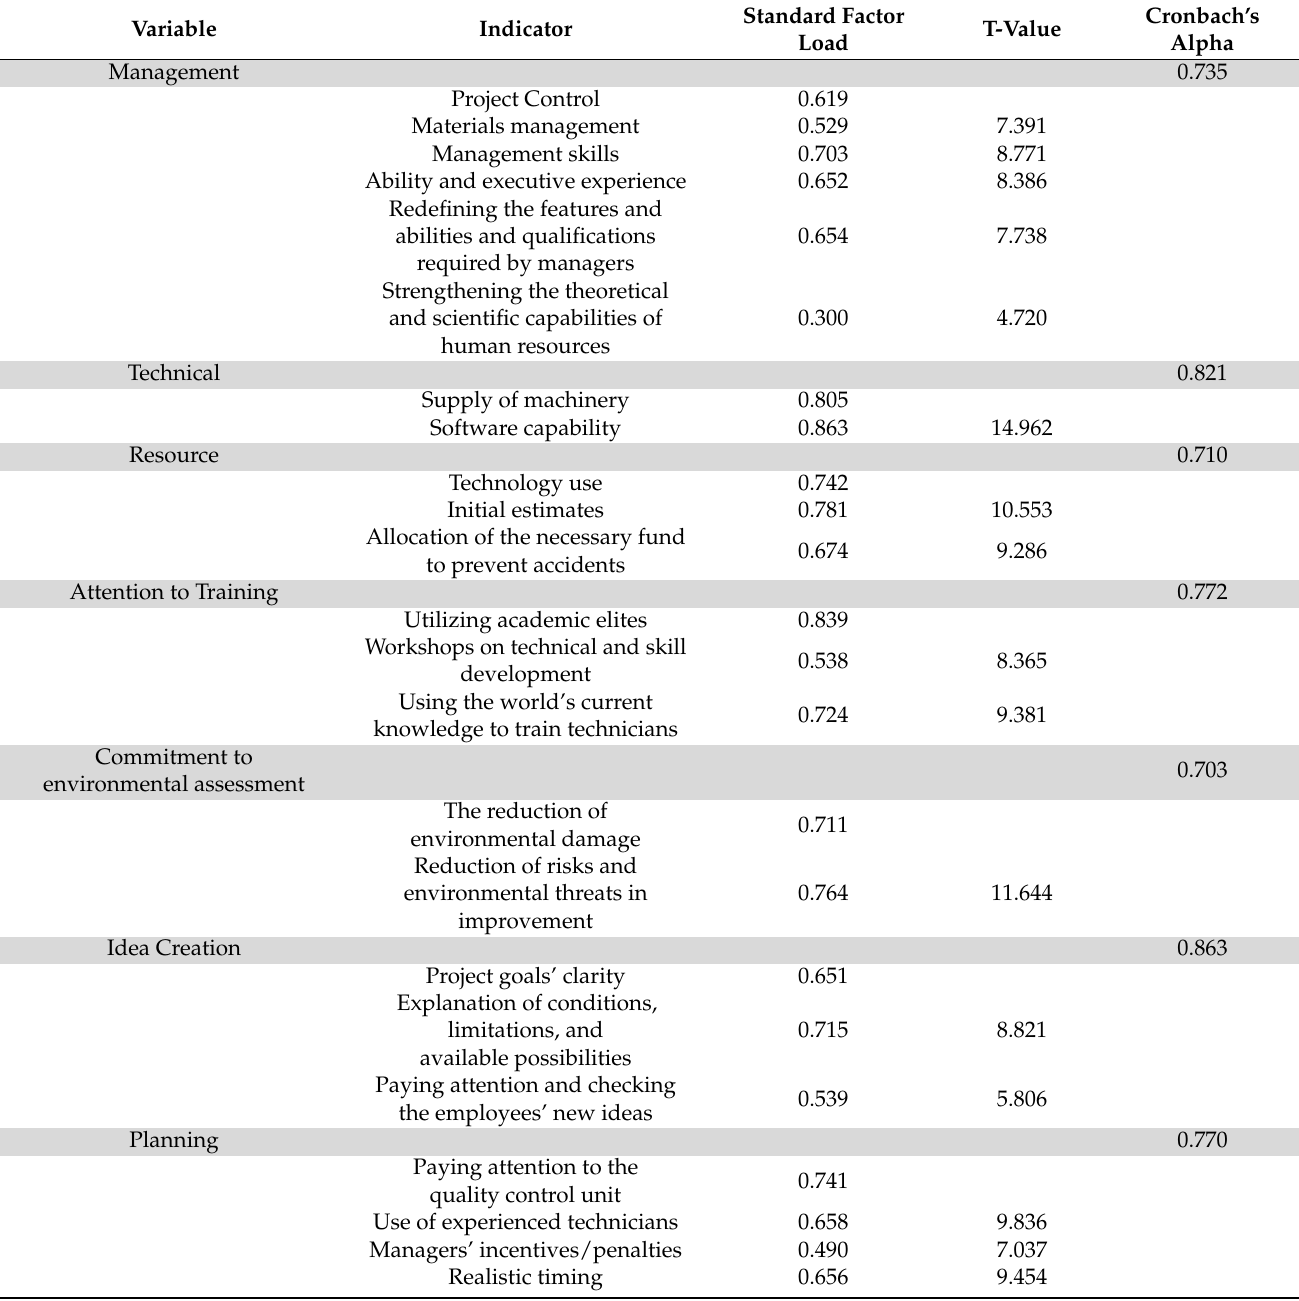
Table 35. The results of the confirmatory factor analysis of the questionnaire.